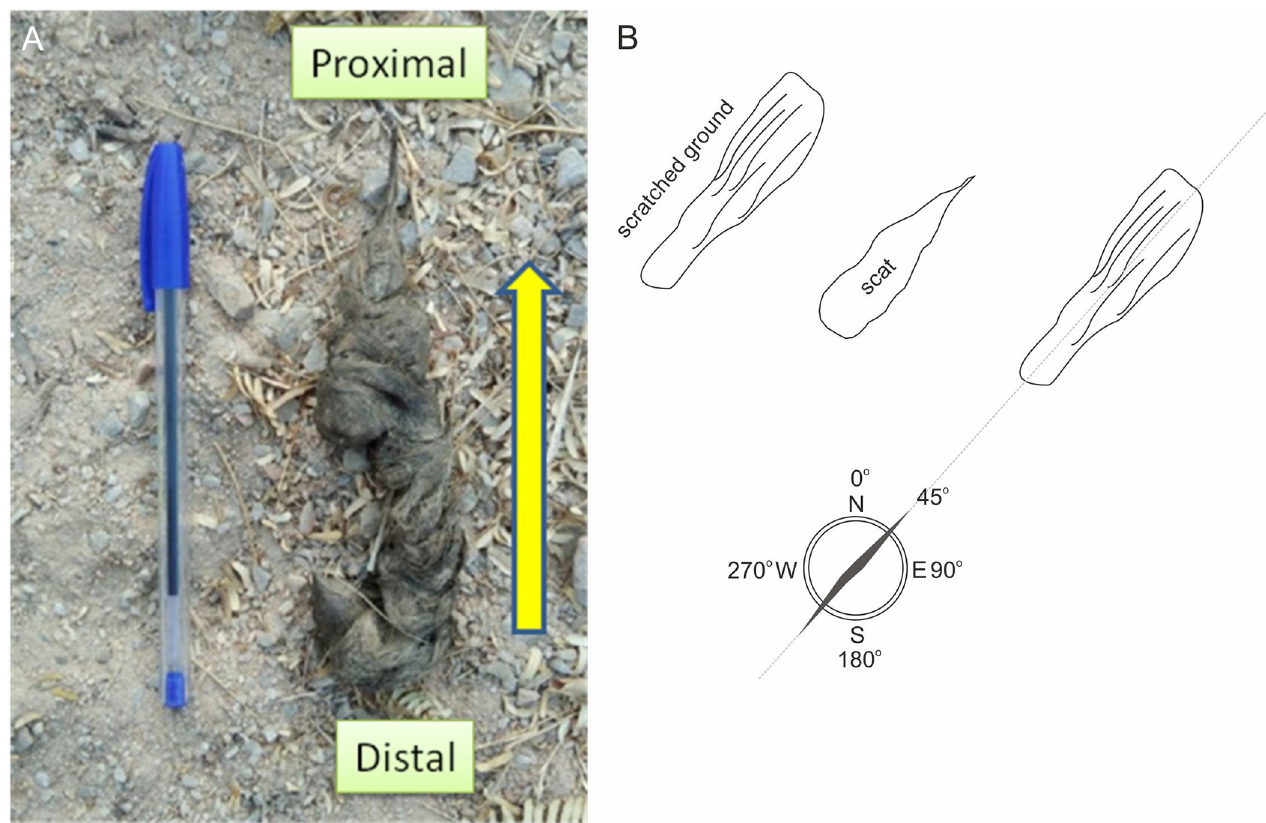
Fig 2. The field techniques used to identify the body alignment of the leopard ( Panthera pardus fusca ) by the elongated part of the scat (A), and a diagram illustrating body orientation during defecation (B). The yellow arrow depicts the direction of the head.